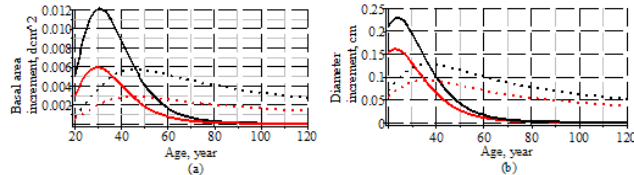
Figure 6. Dynamics of the current and mean annual tree basal area increments of the basal area and diameter, over time, for two randomly selected stands from the validation dataset and mixed-effects scenario: ( a ) basal area increments; ( b ) diameter increments; black color represents the first stand; red color represents the second stand; solid line—the current increment; dotted line—the mean annual increment.